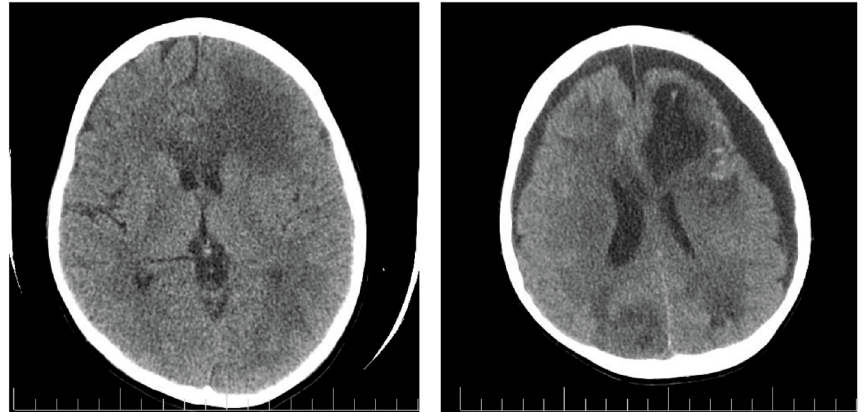
Figure 3: Brain CT scan: di ff use parenchymal hypodensity in left frontal and parietal lobes which suspected to a left-sided arterial stroke.